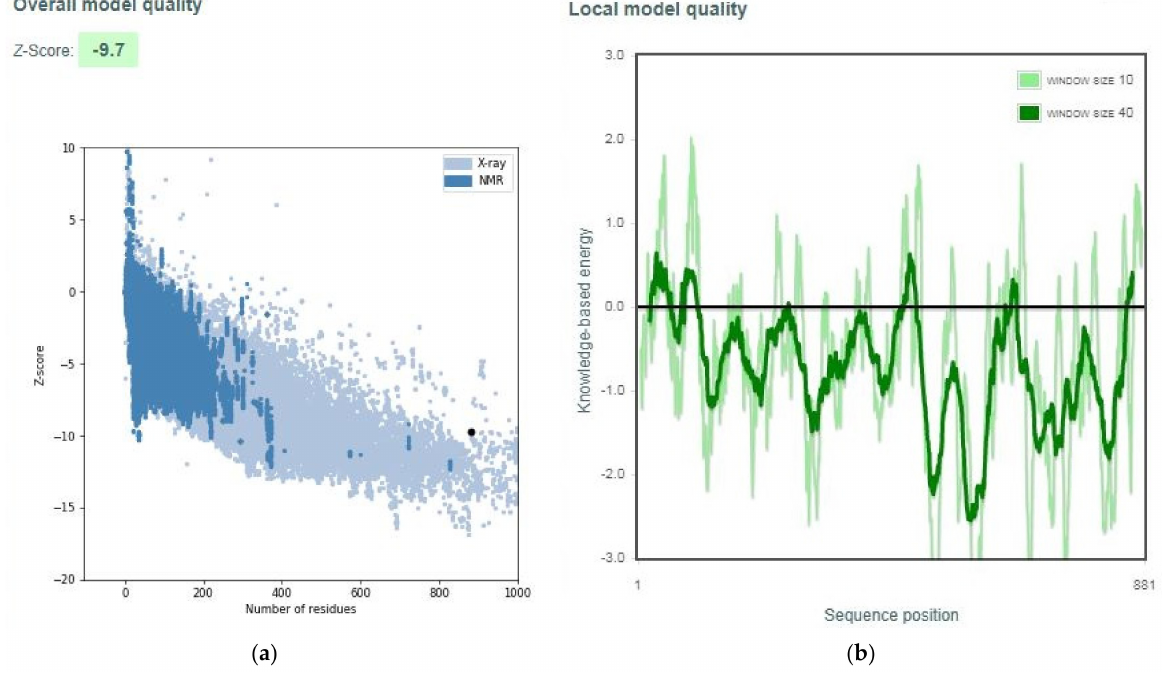
Figure 4. Model quality assessment using ProSA-web. ( a ) A z-score of the best Ld CRK12 structure indicating the overall model quality, and ( b ) a local model quality of the selected Ld CRK12 structure by plotting energies as a function of amino acid sequence